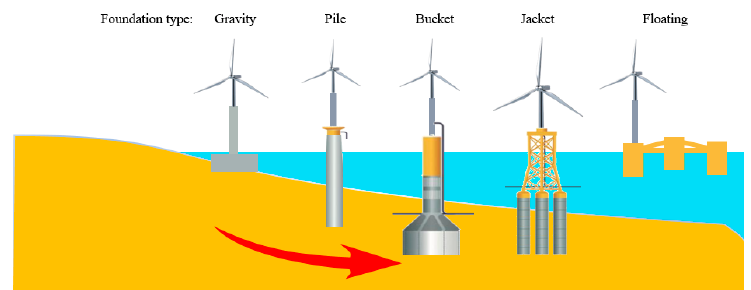
Figure 2. The most common foundation types around the globe.